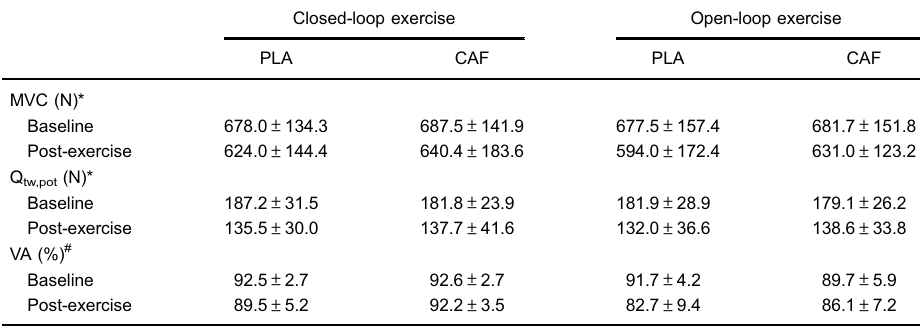
Table 1. Neuromuscular function before (baseline) and after a 4,000-m cycling time trial (closed-loop exercise) and a time-to-task failure trial (open-loop exercise) with caffeine (CAF) and placebo (PLA)